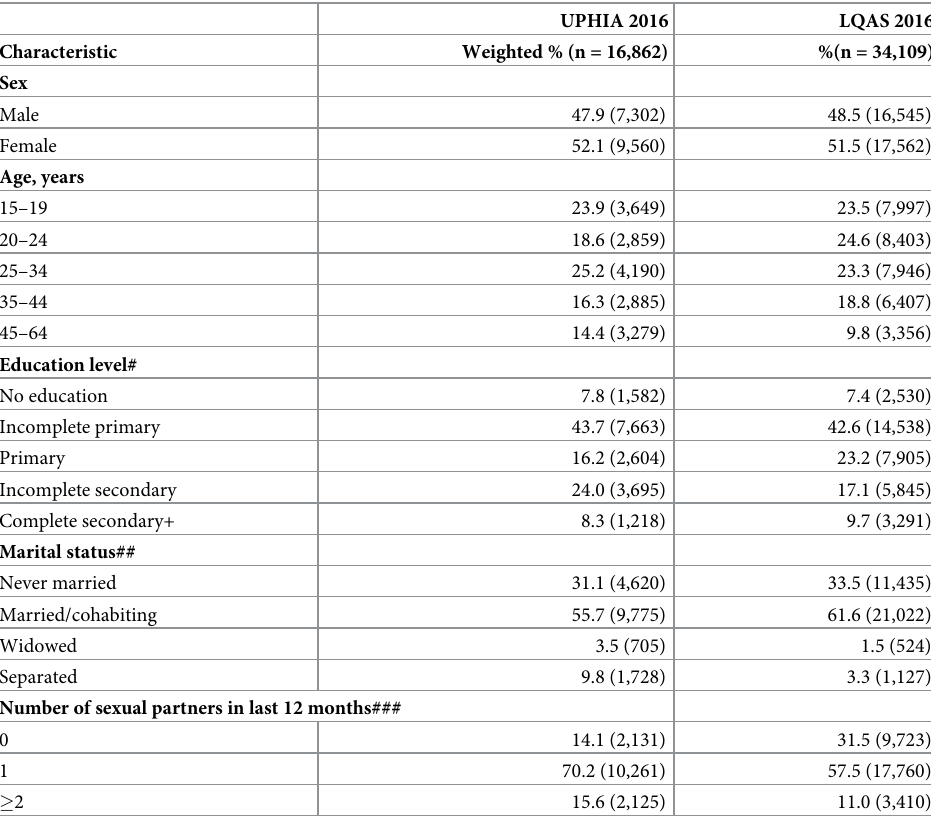
Table 1. Characteristics of respondents.